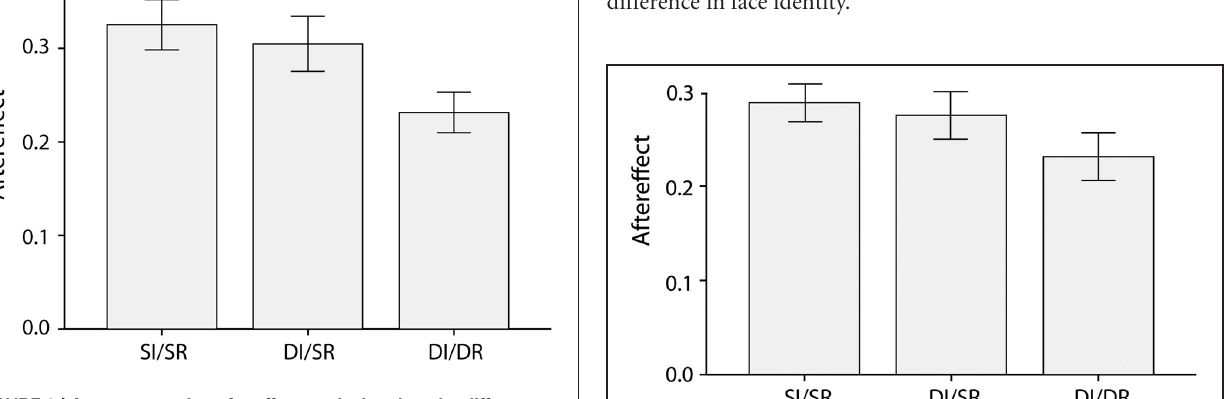
Frontiers in Integrative